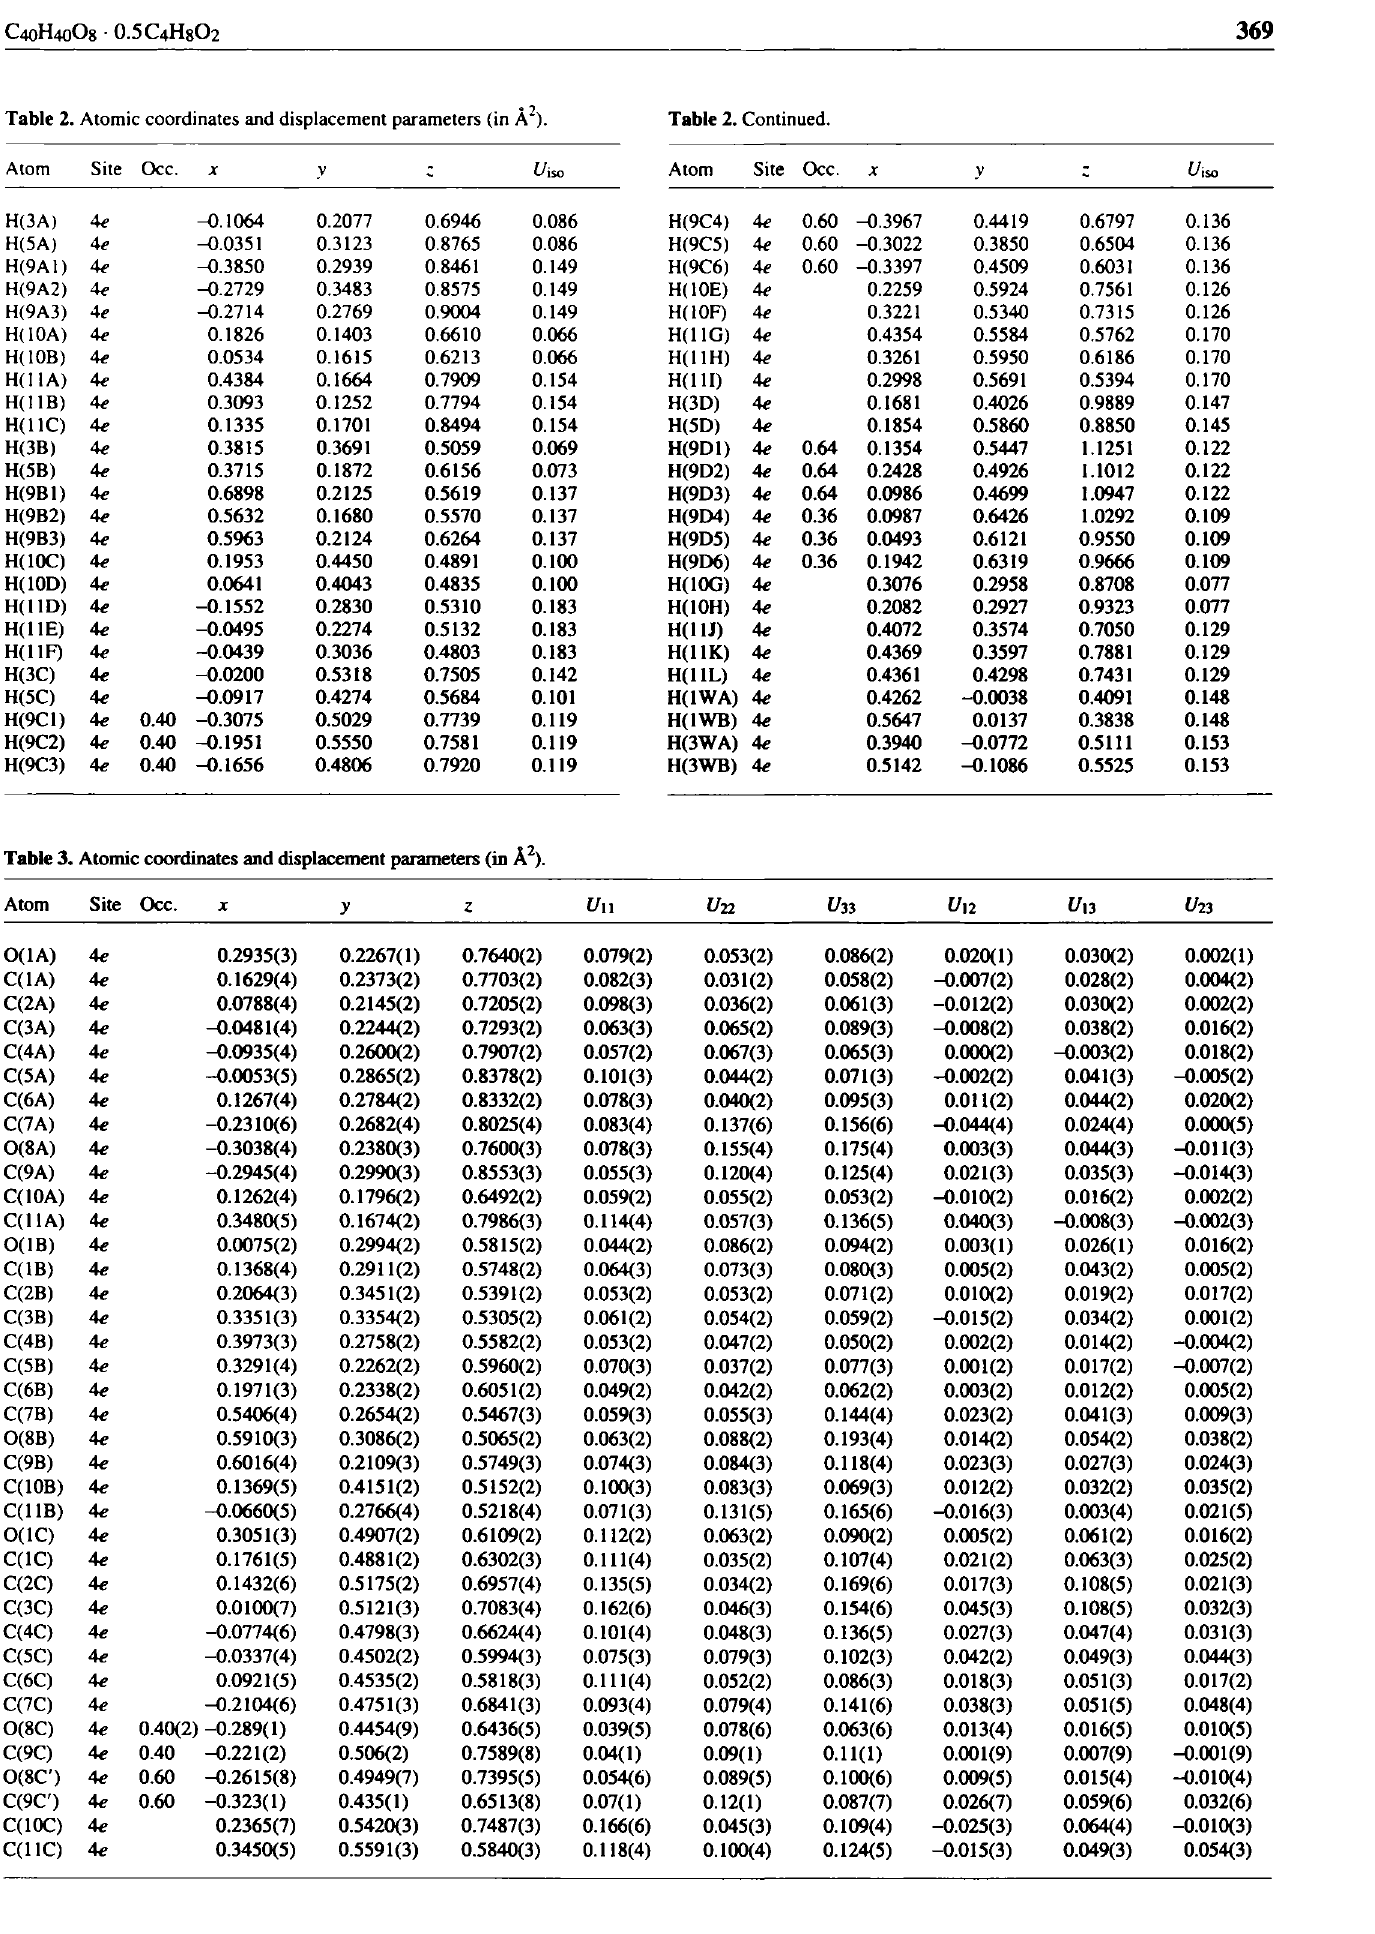
Table 3. Atomic coordinates and displacement parameters (in À 2